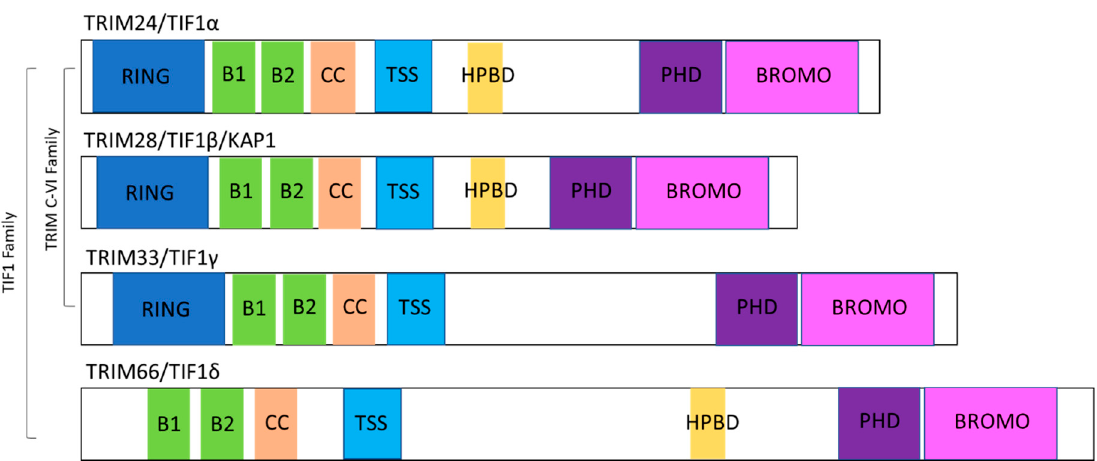
Figure 1. Schematic of the structure of TIF1 family proteins. RING—really interesting new gene, has intrinsic E3 ligase activity; B1 and B2—B-box domains; CC—coiled-coil domain; TSS—TIF1 signature